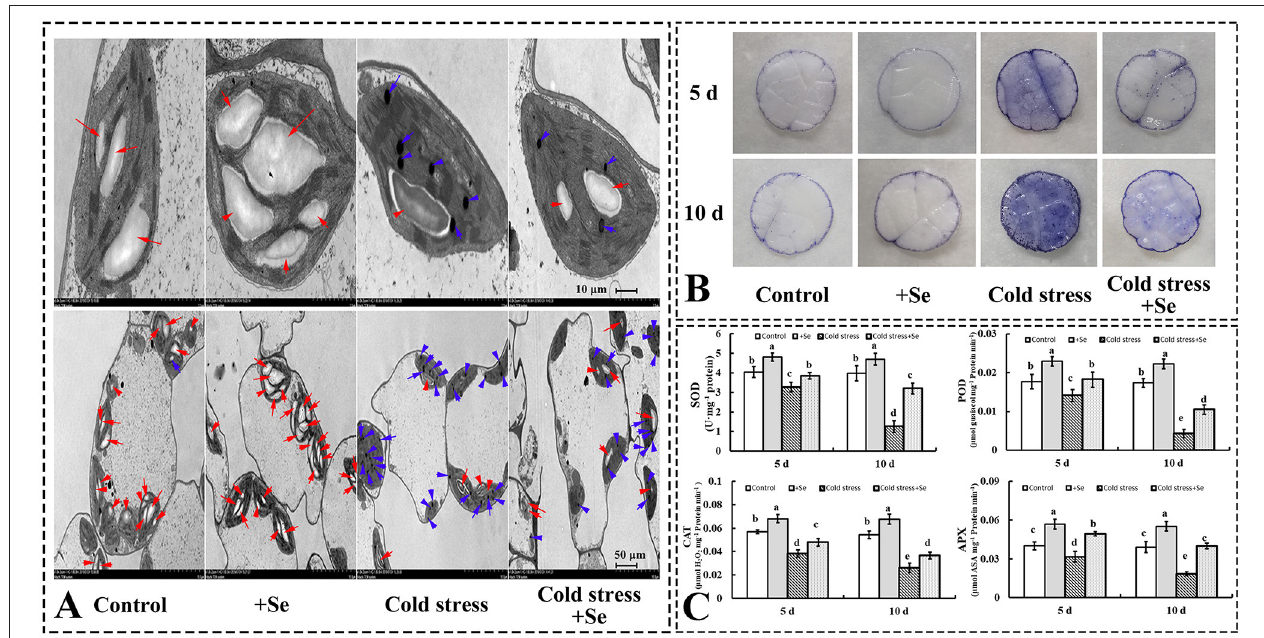
FIGURE 3 | Exogenous application of selenium protected the photosynthetic apparatus and alleviated the oxidative stress induced by cold stress. (A) Ultrastructures of cells of cucumber seedlings leaf of control, selenium application, cold stress, and selenium application under cold stress. Red arrow points to starch grain, blue arrow points to osmiophilic granule. (B) O − 2 in leaves was detected by NBT staining. (C) The activity levels of SOD, POD, CAT, and APX of control, selenium application, cold stress, and selenium application under cold stress with 5 and 10 days treatments, respectively. Values are expressed as means of three replicates ± SD, and different letters are significantly different ( P < 0.05).